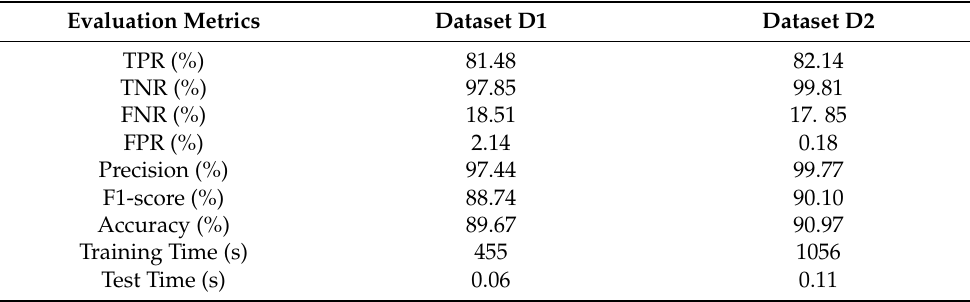
Table 10. Results of the proposed method on datasets D1 and